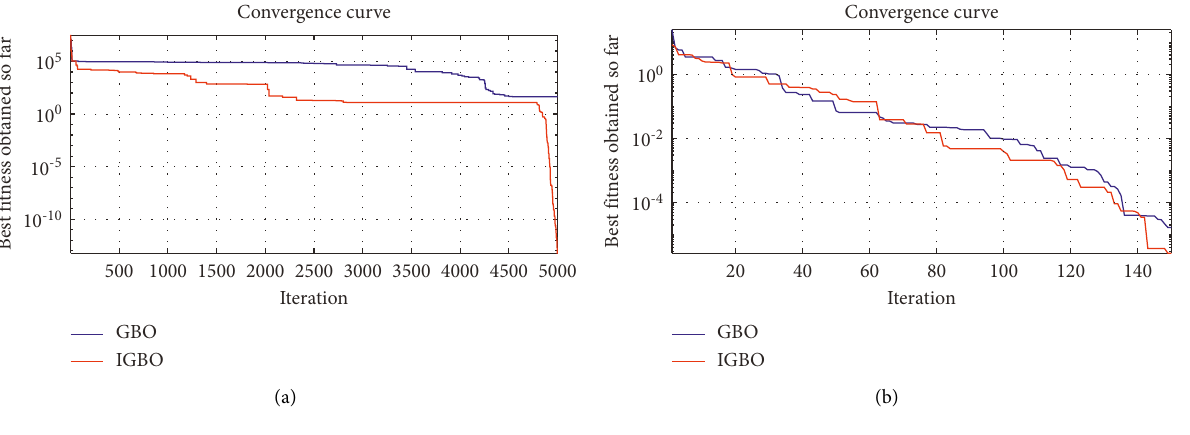
Figure 12: SAE convergence for model 7.